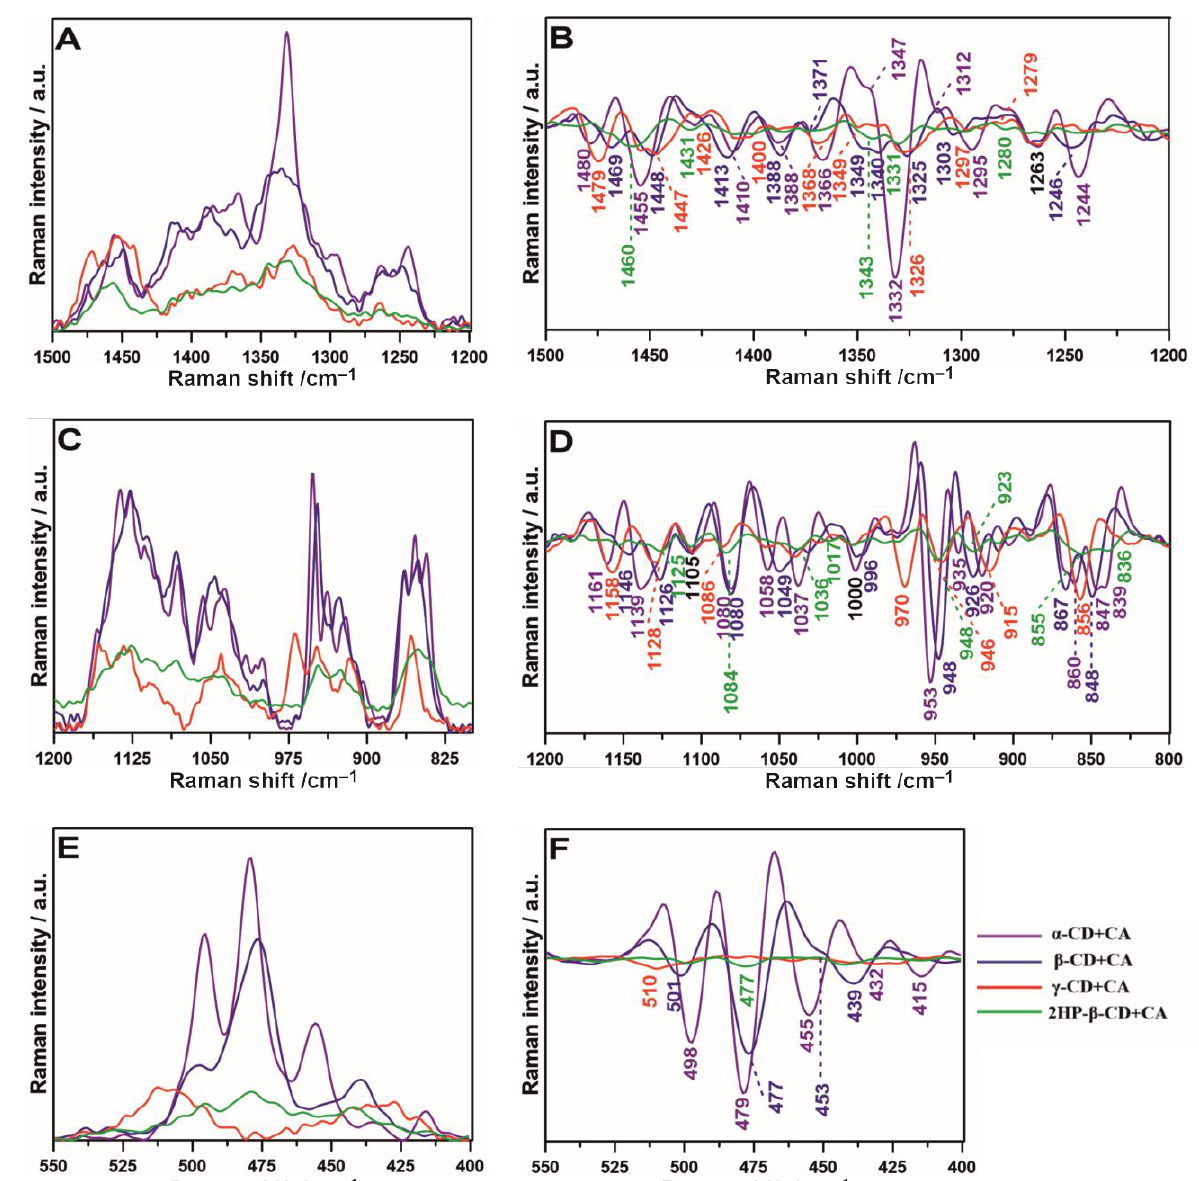
Figure 5. The relative intensities of Raman spectra and their second derivatives in the selected ranges: 1500–1200 cm −1 ( A and B , respectively), 1200–800 cm −1 ( C and D , respectively), and 550–400 cm −1 ( E and F , respectively). Numbers in black indicate the same Raman shift values for all samples.